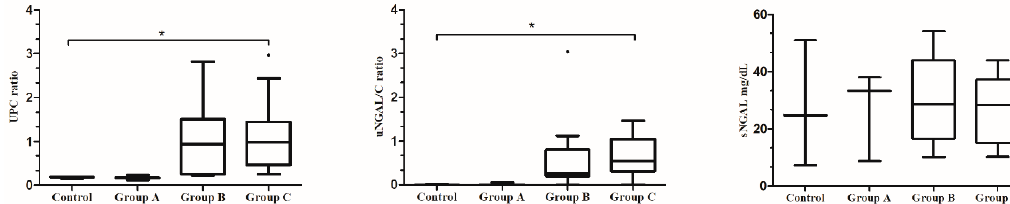
Figure 4. Box plots showing the relationship between UPC, uNGAL/C, and sNGAL and the different groups of dogs according to the glomerular lesion’s classification. Data are presented as boxes and whiskers. Each box includes the 25 and 75 interquartile, whereas the line inside the box represents the median, the whiskers represent the minimum and maximum values. Outliers are shown by a circle. Asterisks indicated significant differences between groups: * p < 0.05.